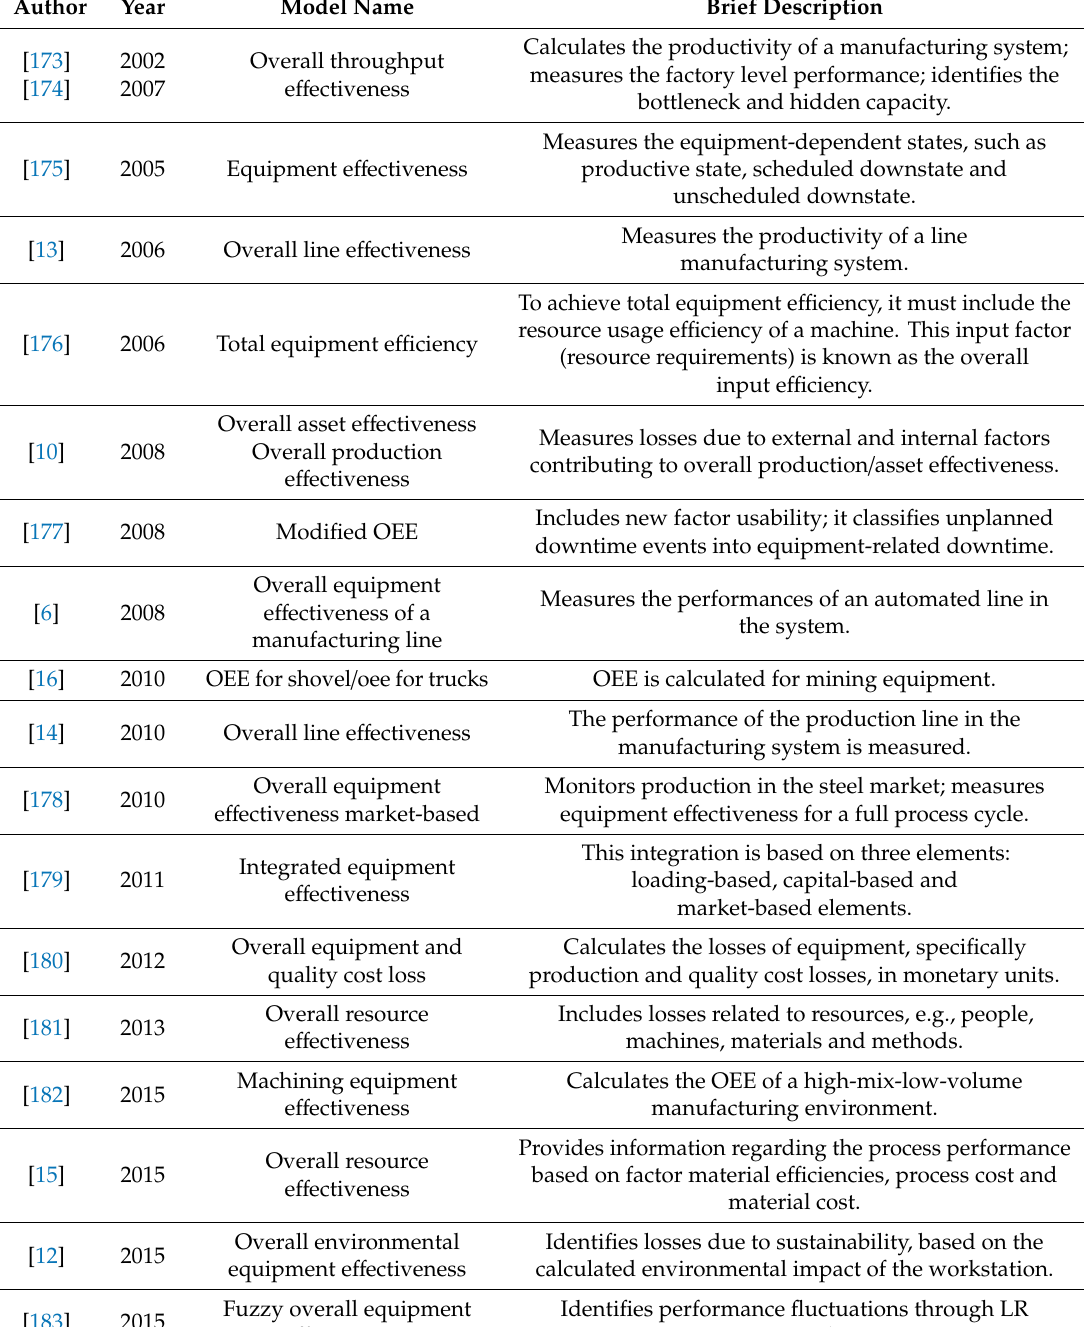
Table 4. List of models based on